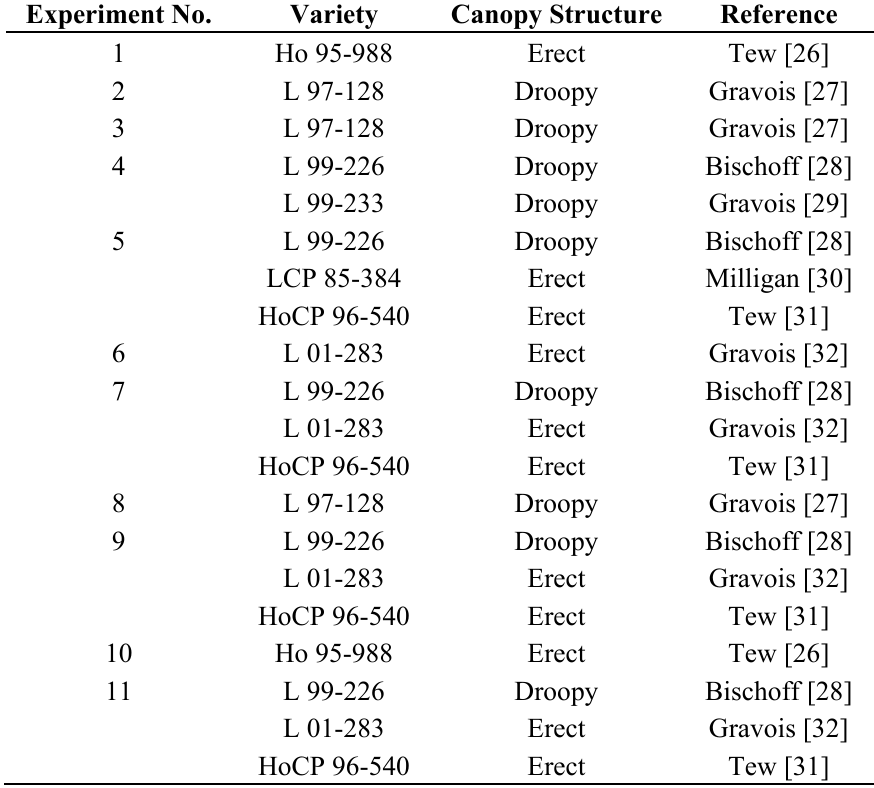
Table 4. Varieties used in all experiments, canopy designation, and source of canopy designation from 2008 to 2011 in St. Gabriel and Jeanerette, LA,